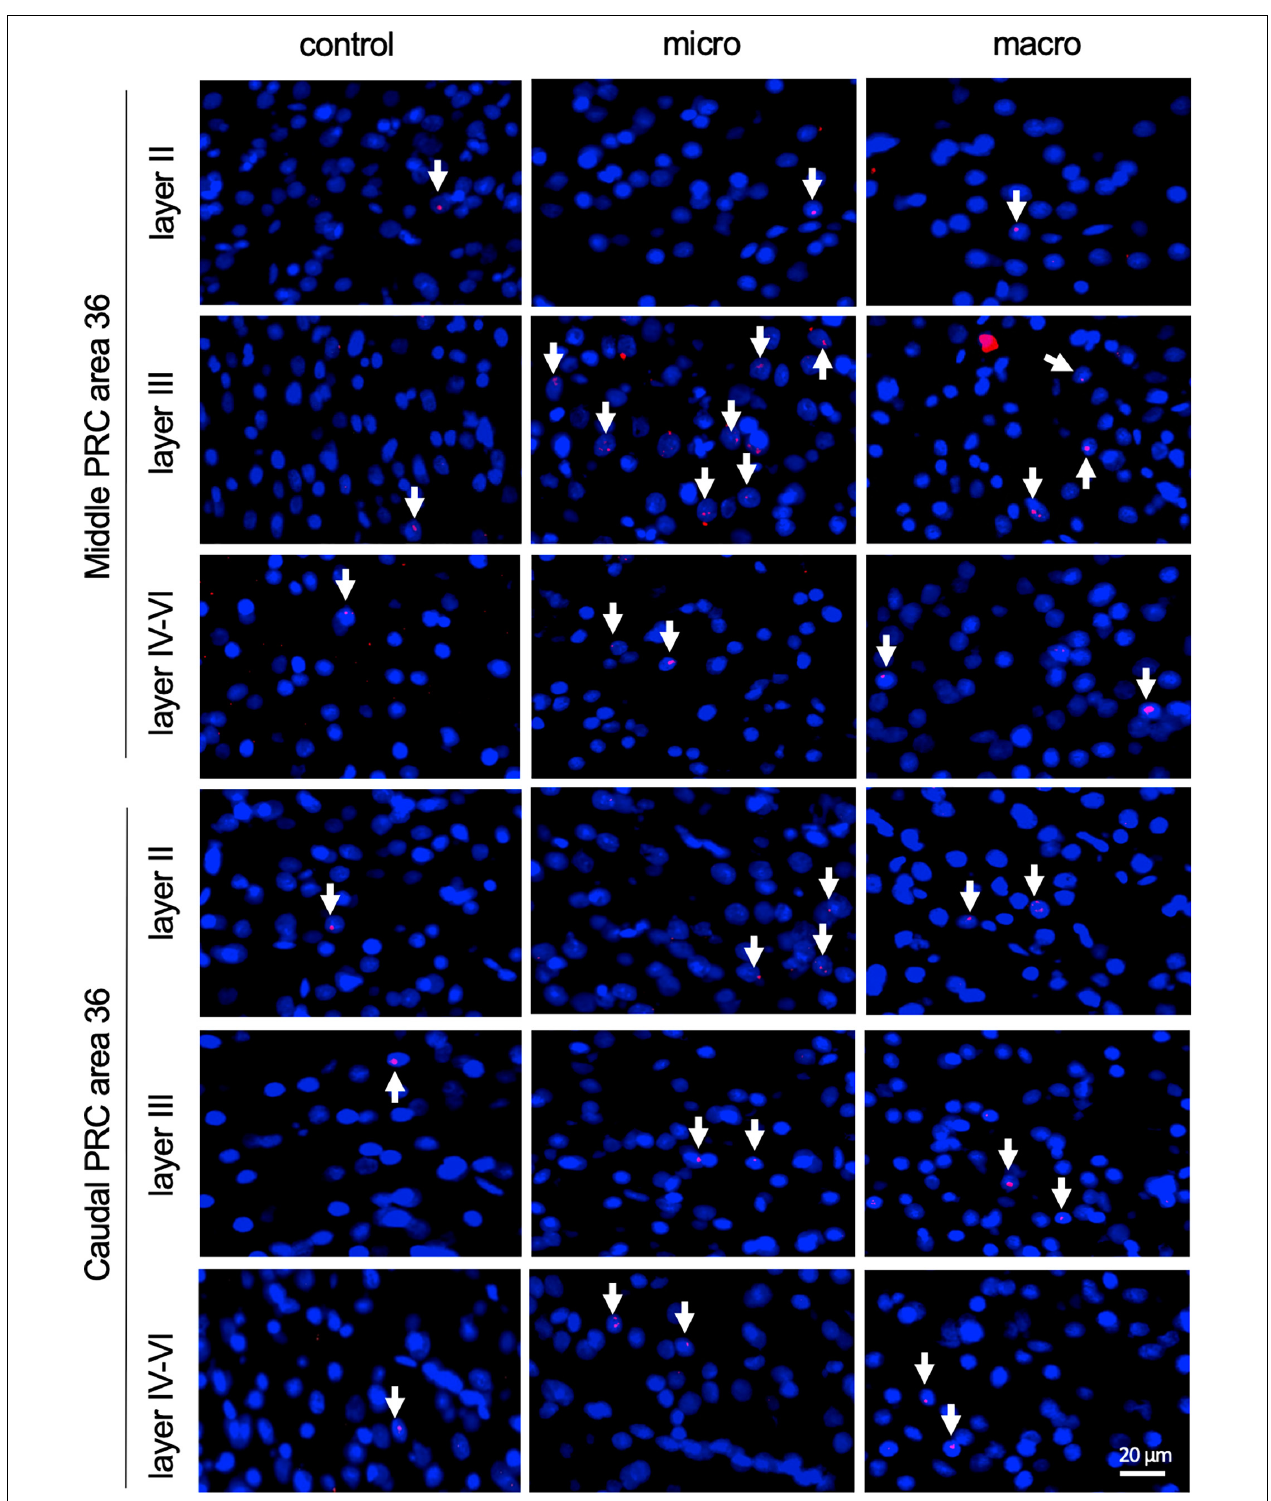
FIGURE 5 | Nuclear Arc mRNA expression in the superficial and the deep layers of area 36 following exposure to novel items. Photomicrographs showing Arc mRNA expression (red, indicated by white arrows) in layer II (top row), III (middle row), and the deeper layers (bottom row) of the middle and caudal of area 36 from control animals (control) or animals that participated in microscale (micro) or macroscale (macro) item exploration. Nuclei (blue) are stained using DAPI. Images were taken using a 20x objective. Scale bar: 20 µ m.